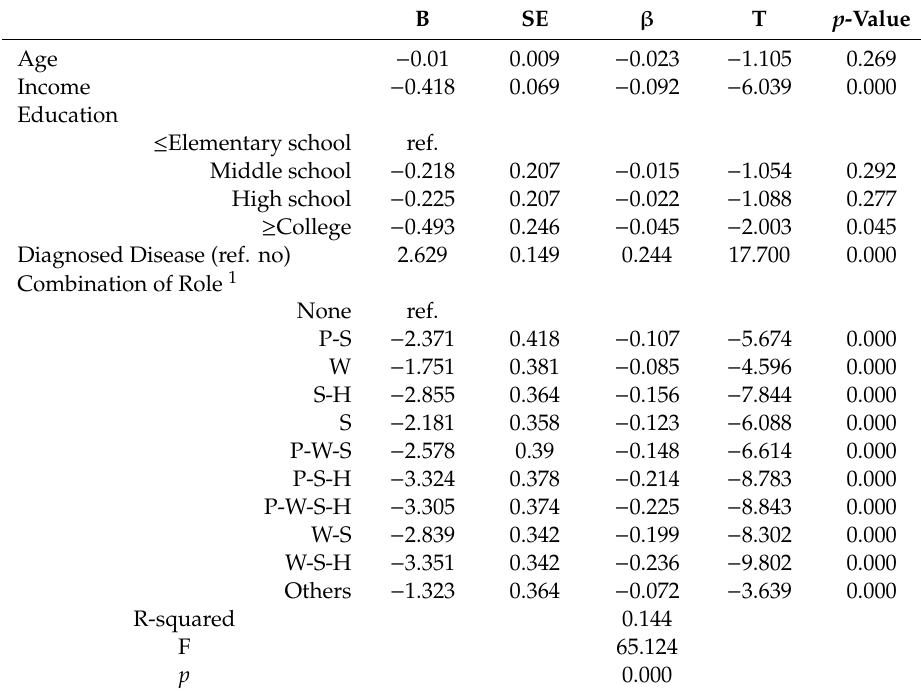
Table 4. E ff ects of the combination of role on depressive